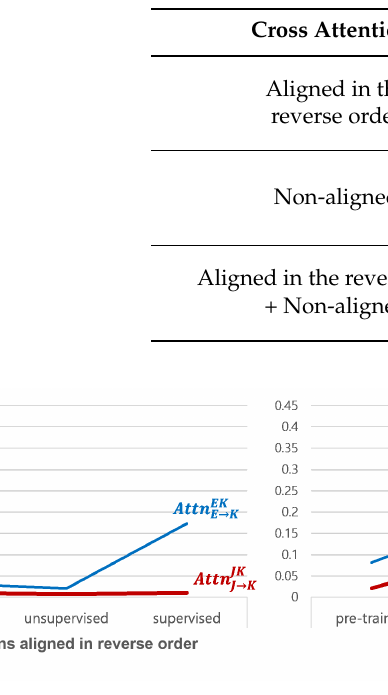
Figure 6. The cross-attentions between Japanese–Korean and